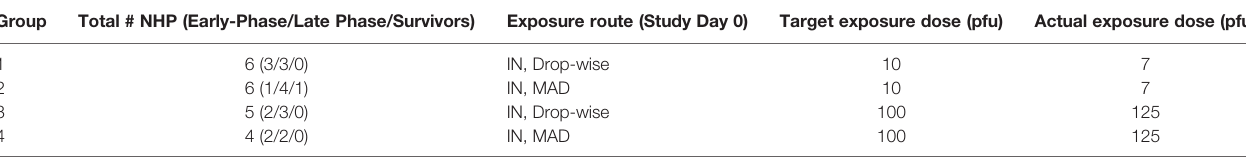
IN, intranasal; MAD, mucosal atomization device; pfu, plaque forming